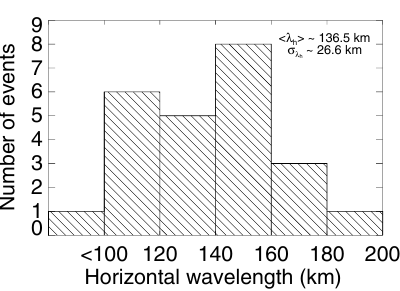
Figure 1. Histogram for the wavelengths of the periodic waves. < λ h > represents the average and σ λ represents the standard de- h viation of the mean. Table 1 shows all parameters of the studied periodic waves. Notice that the intrinsic parameters are denoted by the index “i”, the observed parameters are represented by the index “o”. The propagation direction is represented by φ and increases clockwise from the north. The horizontal compo- nents of the wind were represented by U and V for zonal and meridional components, respectively. The “Events” col- umn represents the sequential order used in Figs. 4 and